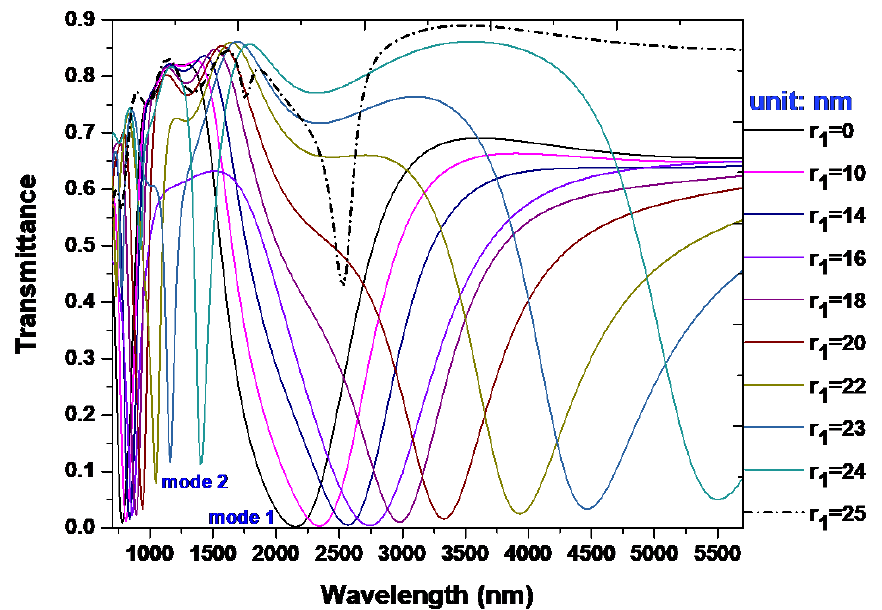
Figure 6. Transmittance spectra for different radius of the silver nanorods with r 1 = (0, 8, 10, 12, 14, 16, 18, 20, 22, 23, 24, 25) nm, respectively. The other parameters are set as the same as used in Figure 2.